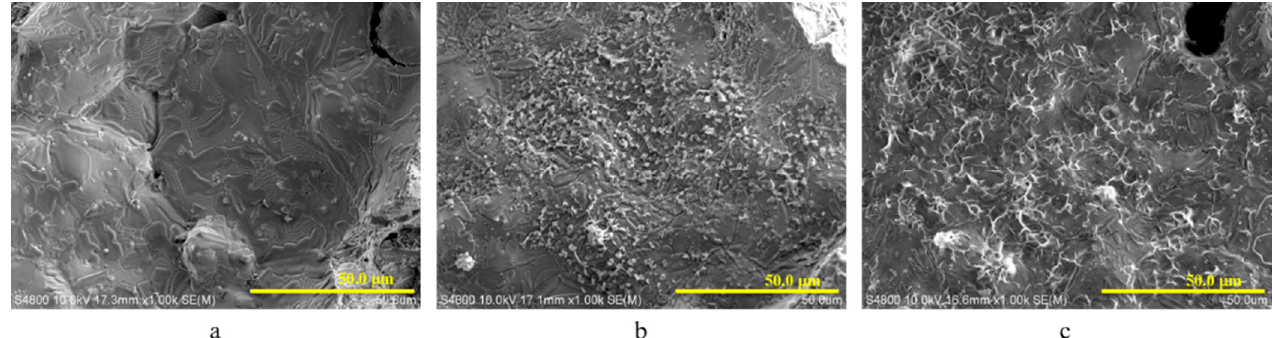
Figure 2. SEM images of the internal pore structure of sintered 440C stainless steel samples after zinc acetate electrodepo- sition. The amount of NaCl is 10 wt.% ( a ), 20 wt.% ( b ), and 30 wt.% ( c ).